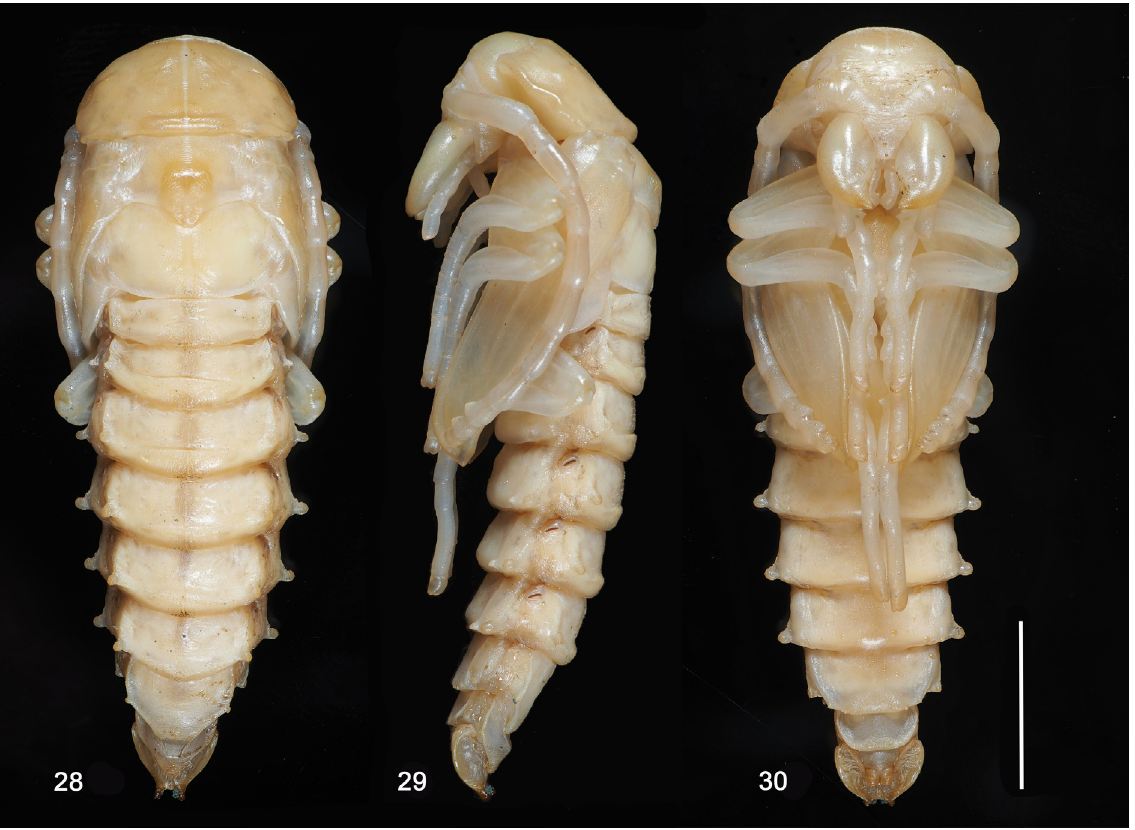
Figs 28–30. Pupa of Trictenotoma formosana Kriesche, 1919. 28 . Dorsal view. 29 . Lateral view. 30 . Ventral view. Scale bar: 10